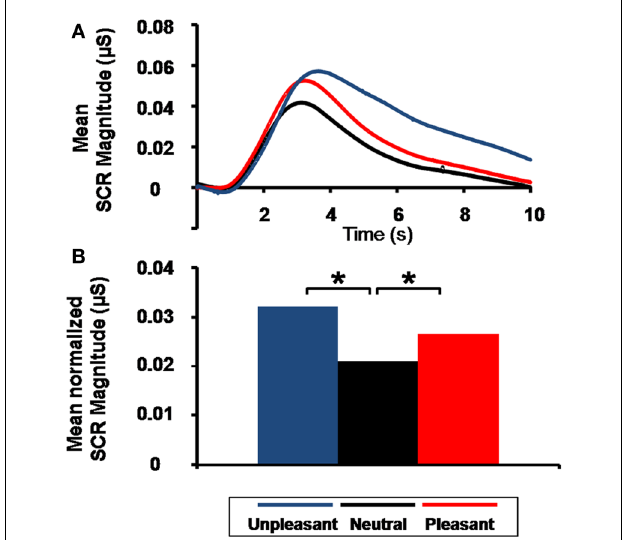
FIGURE 3 | Emotional arousal effect on skin conductance response (SCR). (A) Grand average of SCR as a function of time and emotional content. (B) Mean normalized SCR magnitude as a function of emotional content (* p = 0.003).